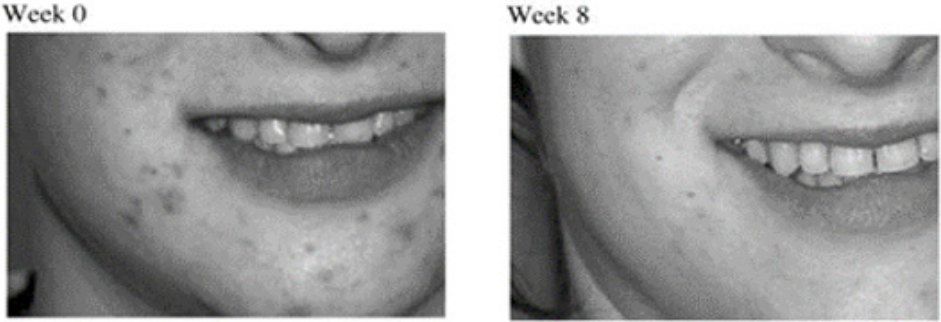
Figure 3. Photographs of a patient with moderate acne treated with clindamycin phosphate and salicylic acid ethosomal gel for 8 weeks at the baseline (week 0) and at the end of the study (week 8) (Reproduced from reference [31] with permission).